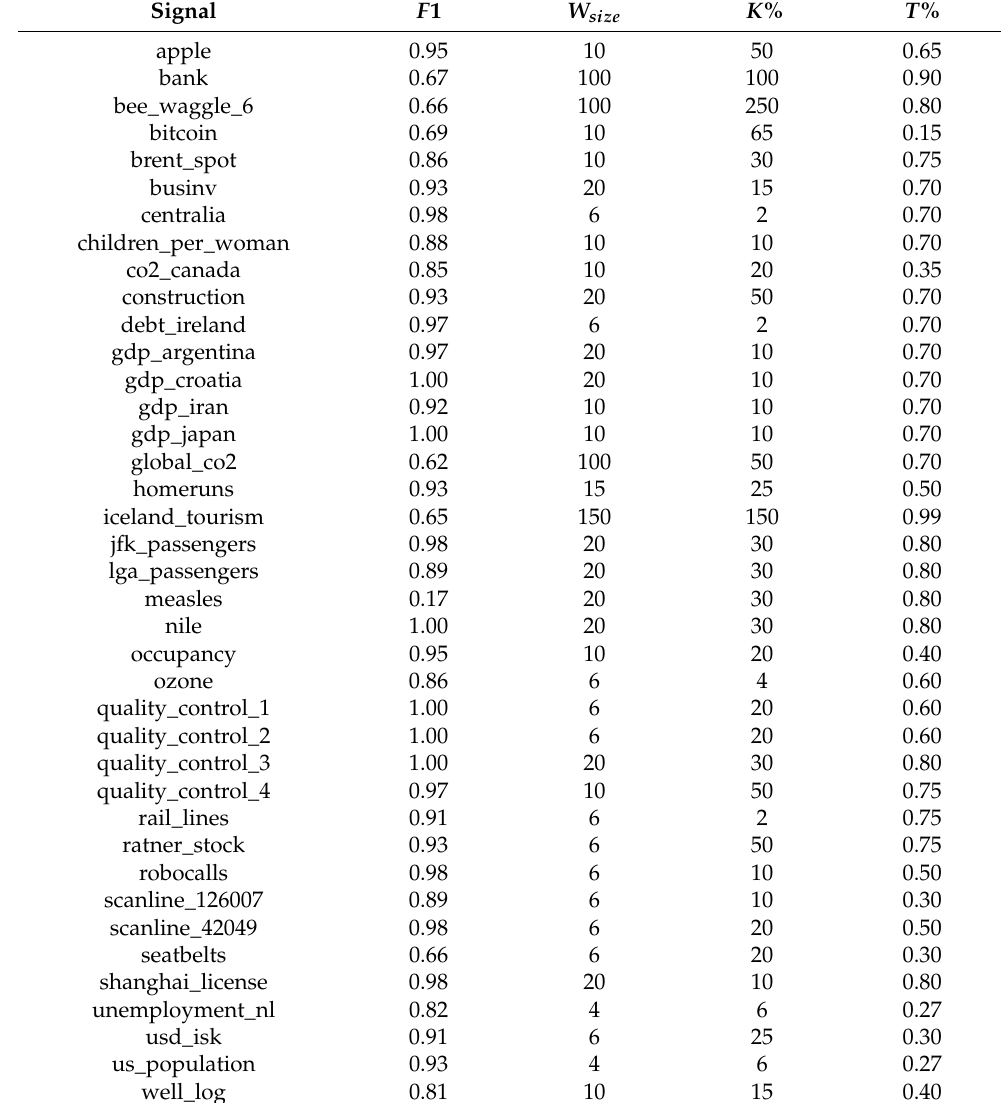
Table A6. Parameter configuration and novelty function-based experimental results of each signal in Dataset 5 (CPDBenchmark, see Section 3.5). W size : window size; K %: kernel size in percentage of the window size; T %: amplitude threshold for event detection; The tolerance corresponded to five samples, specified by the benchmark specifications